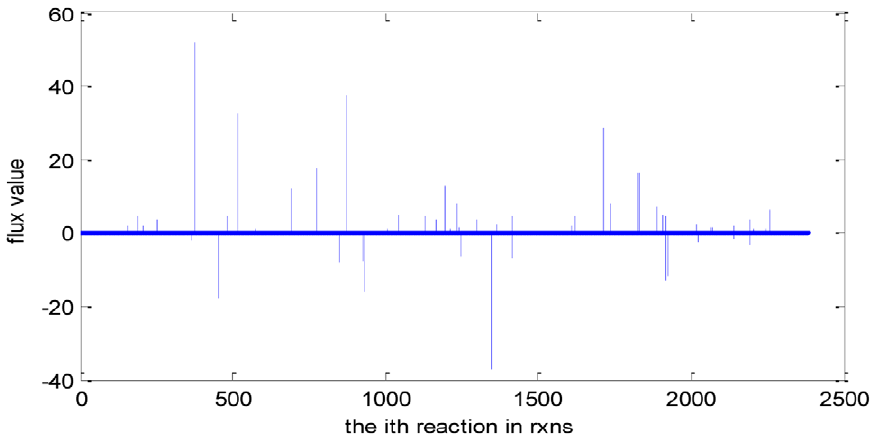
Figure 1. Flux distribution of E.coli _iAF1260. X -axis indicating every reaction in rxns (the order is as the same as in rxns , total 2382) and y -axis indicating the value of its corresponding flux (unit is mmol gDW 2 1 h 2 1 ). Rxns is the reaction set in the model.